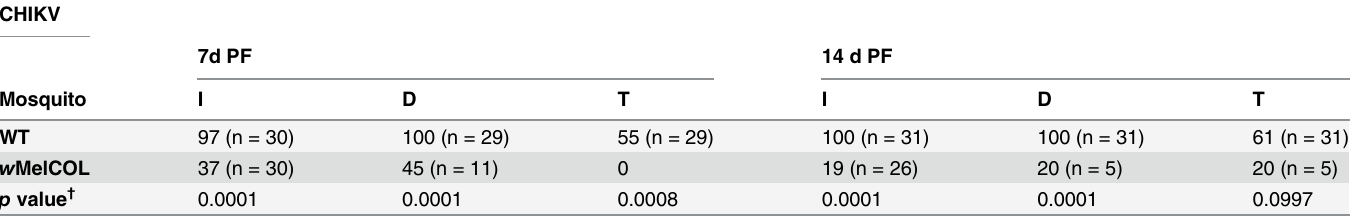
Table 1. Vector competence of Colombian mosquitoes following peroral infection. *